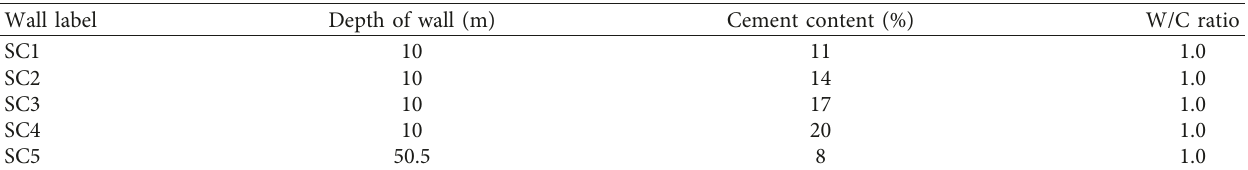
Table 2: Onsite TRD trial wall parameters.